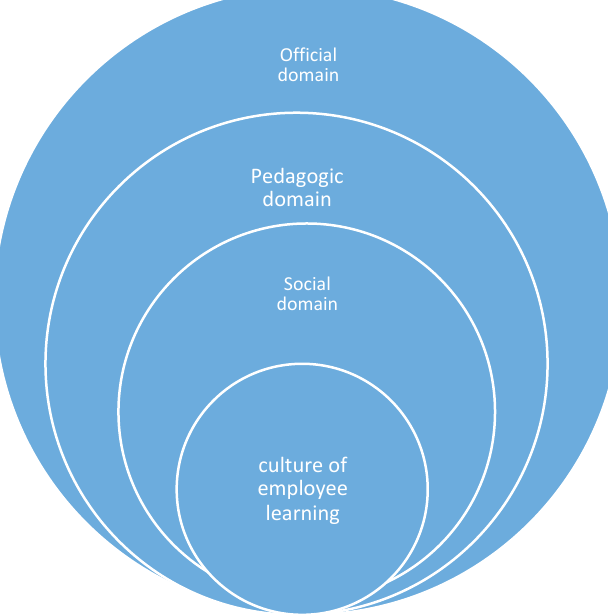
Figure 1: Conceptualising the culture of employee learning Implications of going beyond the official